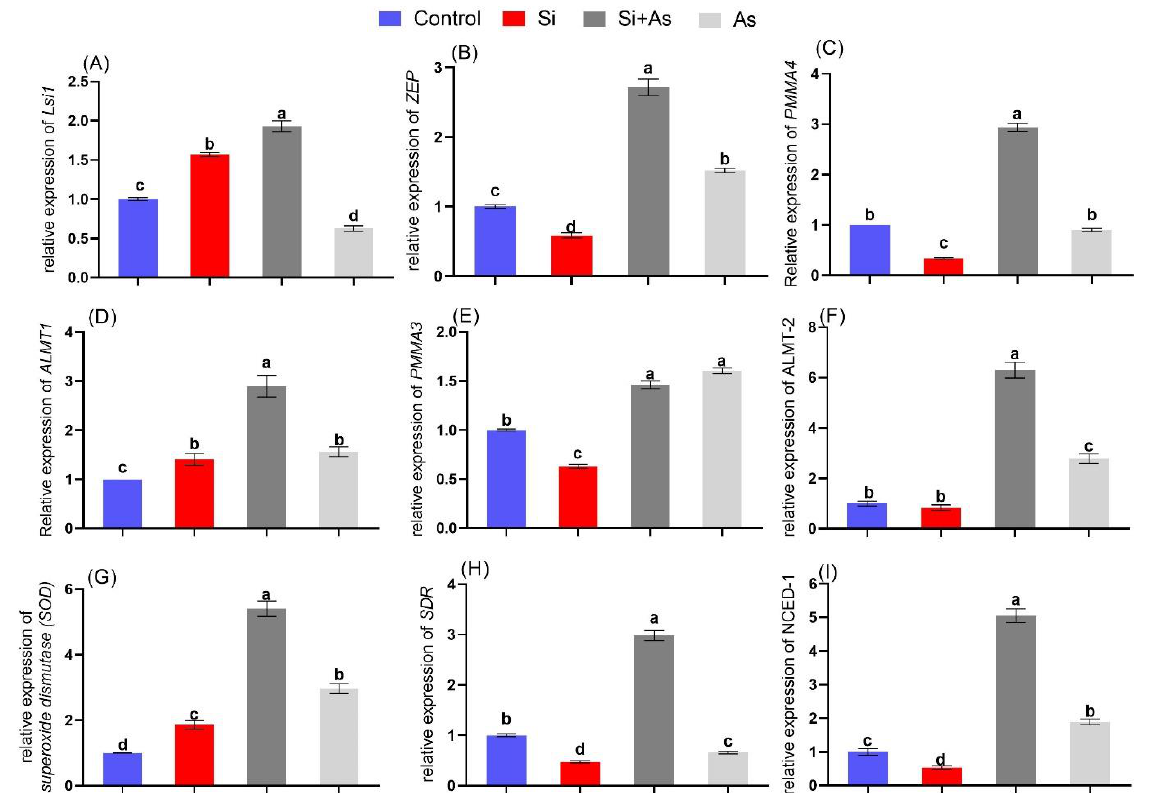
Figure 12. Influence of silicon on expression pattern of abiotic stress-related genes in date palm seedlings under metal stress. Data represented as mean ± standard error. The letters denote significant difference among treatments evaluated by Duncan’s multiple range test